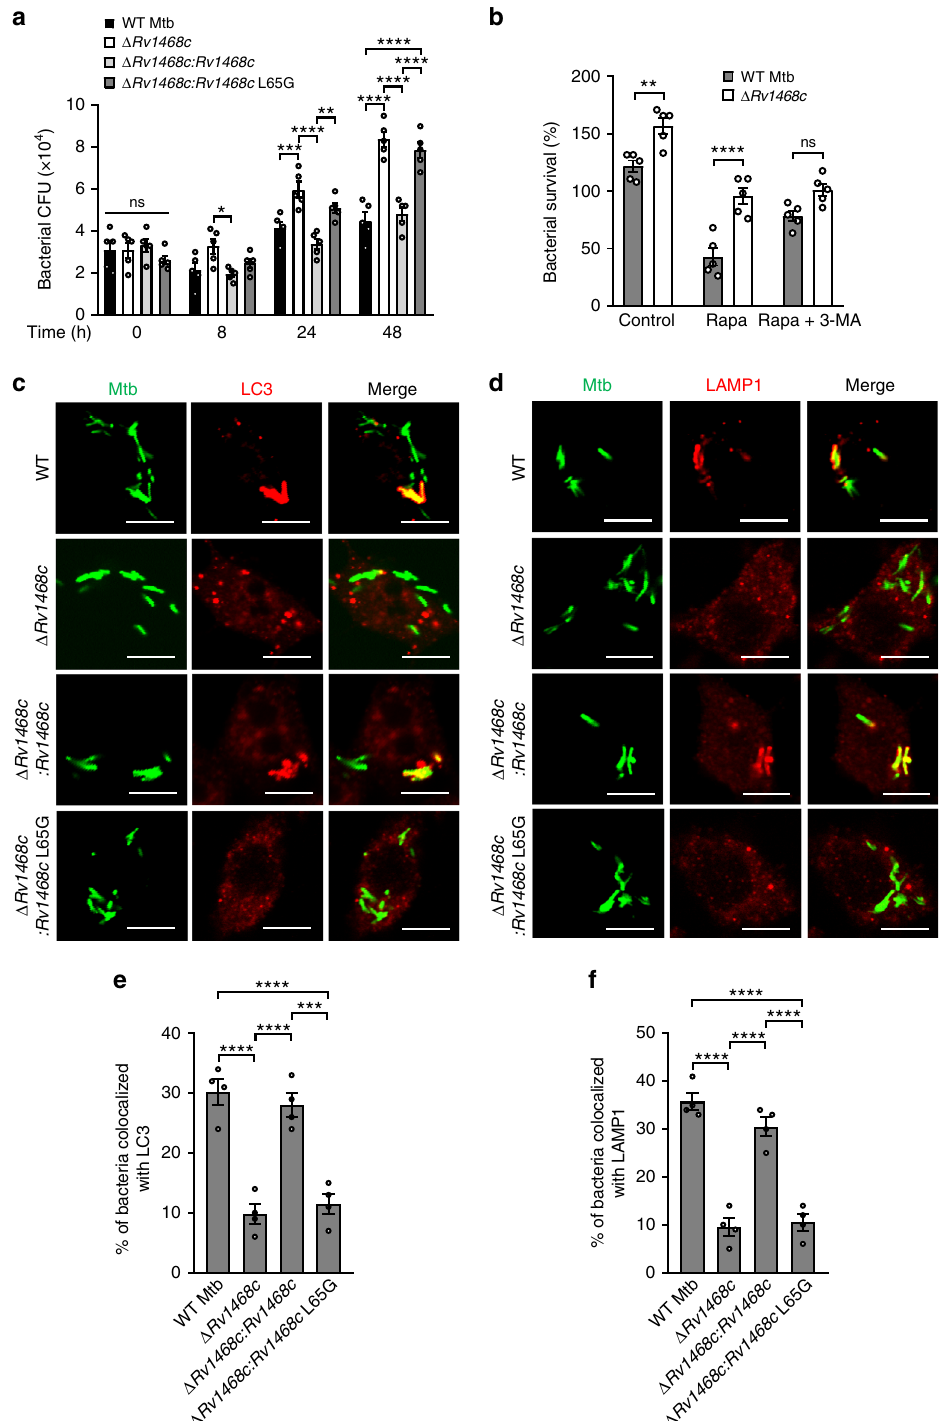
Fig. 4 Deletion of Rv1468c promotes intracellular survival of Mtb and reduces colocalizations of Mtb with LC3 and LAMP1. a , b Survival of Mtb in BMDMs. Cells were infected with the indicated Mtb strains at MOI = 1 for 0 – 48 h ( a ), or 24 h after being treated with 50 μ M rapamycin (Rapa), 50 μ M Rapa along with 10 mM 3-methyladenine (3-MA), or equal volume of DMSO (Control) for 4 h ( b ). P > 0.05, not signi fi cant (ns); * P < 0.05; ** P < 0.01; *** P < 0.001; **** P < 0.0001 (two-way ANOVA). c , d Confocal microscopy analysis for colocalizations of Mtb with LC3 or LAMP1. BMDMs were infected with each of the indicated bacterial strains at MOI = 5 for 24 h and were then immunostained using anti-LC3 ( c ) or anti-LAMP1 ( d ) antibody (red). Bacteria (green) were prestained with Alexa Fluor 488 succinimidyl ester before infection. Scale bars, 5 µ m. e , f Percent colocalization of the indicated Mtb strains with LC3 ( e ) or LAMP1 ( f ) in macrophages infected as in c and d . A total of 100 bacterial cells were counted. **** P < 0.0001 (one-way ANOVA). Results are representatives from at least three independent experiments (mean ± s.e.m. of n = 5 in a , b ; n = 4 in e , f ). The source data used in a , b , e , f are provided in Source